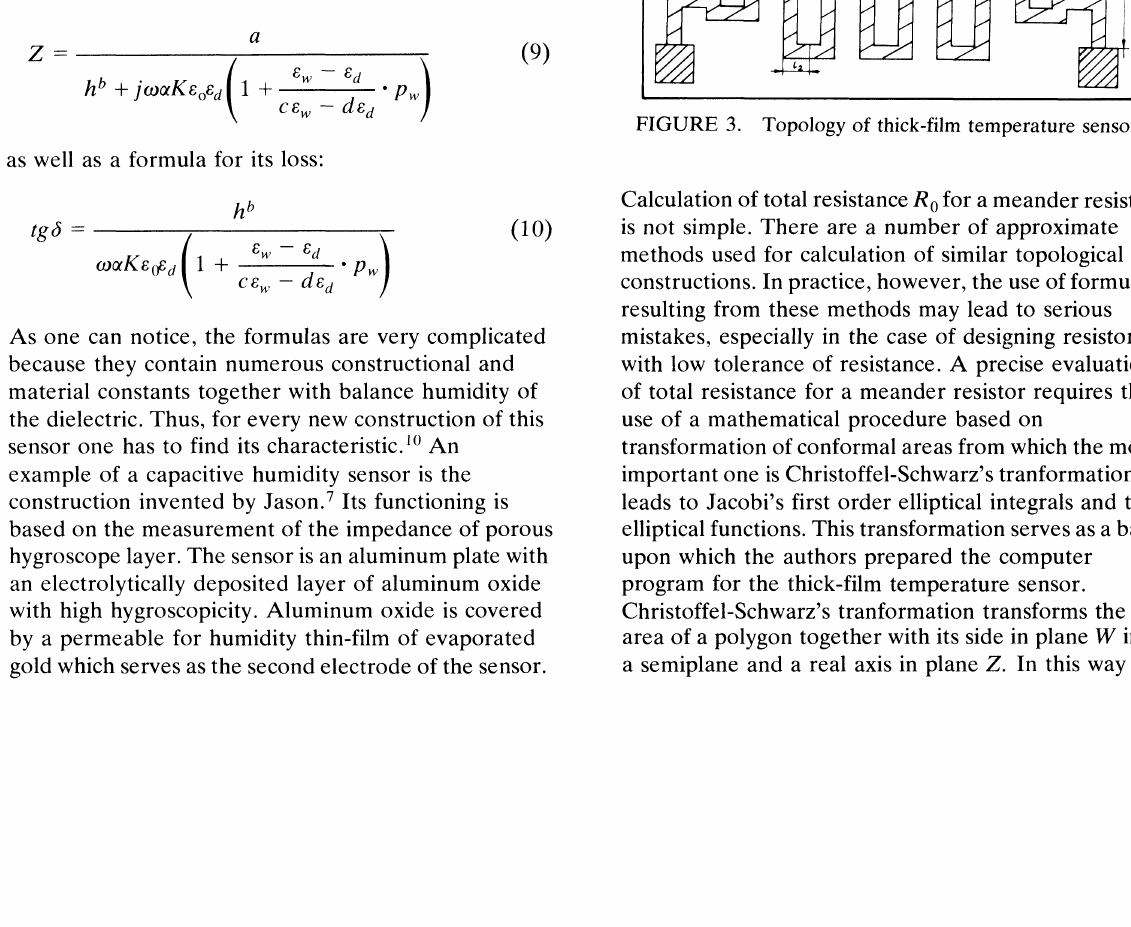
FIGURE 3. Topology of thick-film temperature sensor. Calculation of total resistance R for a meander